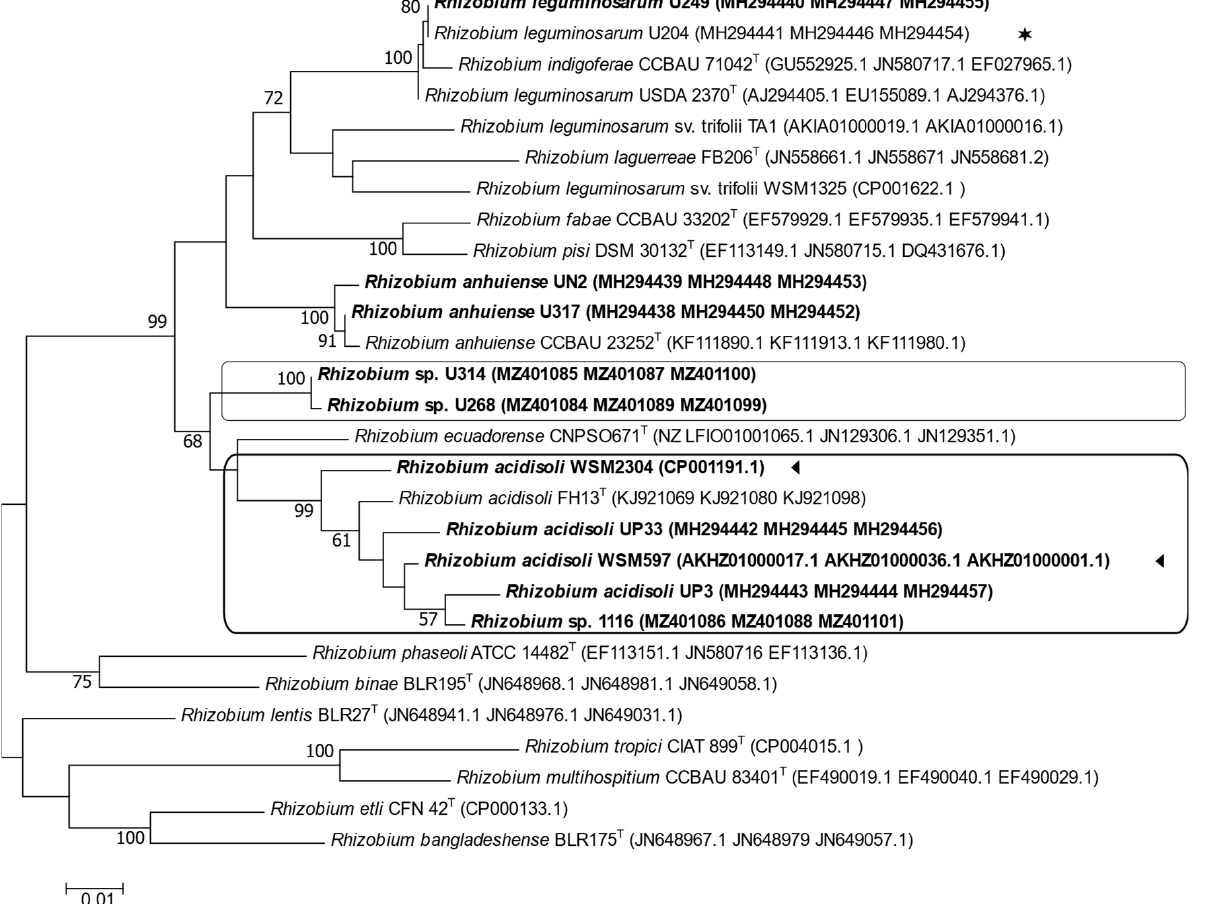
Figure 3. Maximum likelihood tree inferred from concatenated sequences of the housekeeping genes atpD , glnII , and recA . All strains isolated from Uruguayan soils are indicated in bold letters. ( ◄ ), native strains whose genome sequences are available; ( ), the commercial inoculant. Each group is identified with a box. Bootstrap values of 50 or more (based on 1000 replicates) are indi- cated.